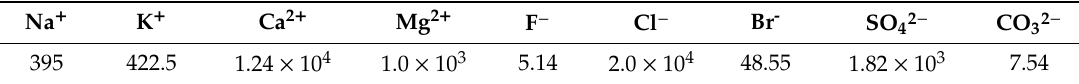
Table 3. Concentrations of main chemical ions in seawater (unit is mg/L).